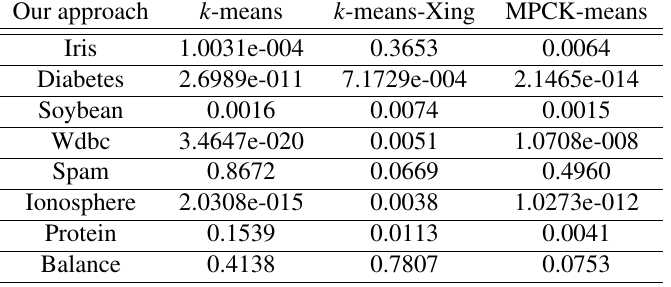
Table 5. t -test under F-measure